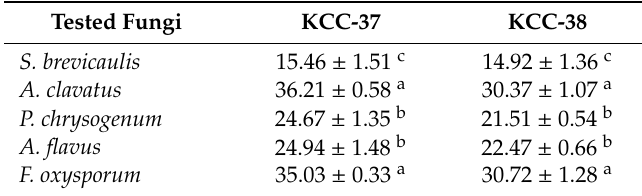
Table 5. Antifungal activities of L. plantarum KCC-37 and L. plantarum KCC-38 against di ff erent fungi, screened by pour plate